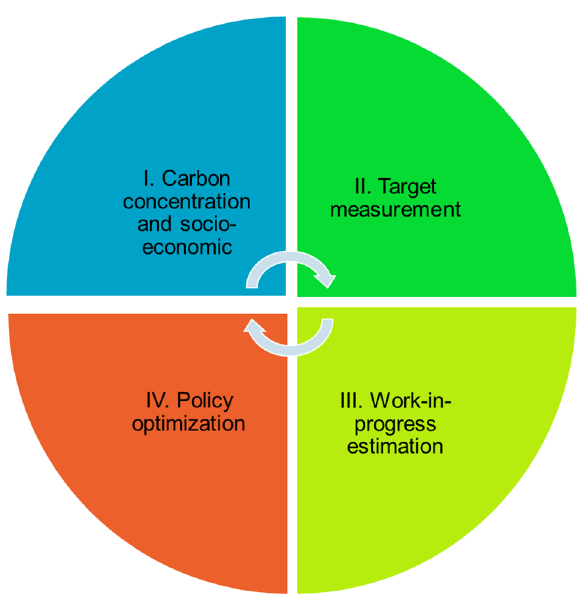
Figure 4. China’s carbon neutrality governance. Source: Designed by the authors.